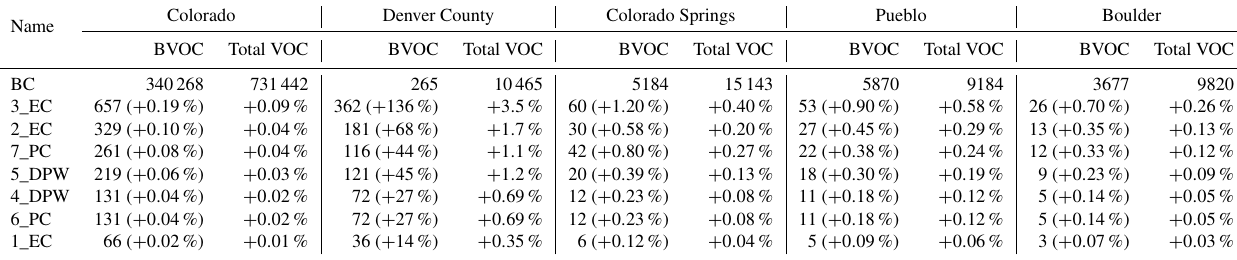
Table 2. The estimated BVOC and total VOC emission rates (tyr − 1 ) for the base case (BC) scenario. Also shown are the increases in VOC emissions for all scenarios shown in Table 1 for Colorado, Denver County, Colorado Springs, Pueblo, and Boulder. The numbers in parentheses are the percentage increases compared with the BC